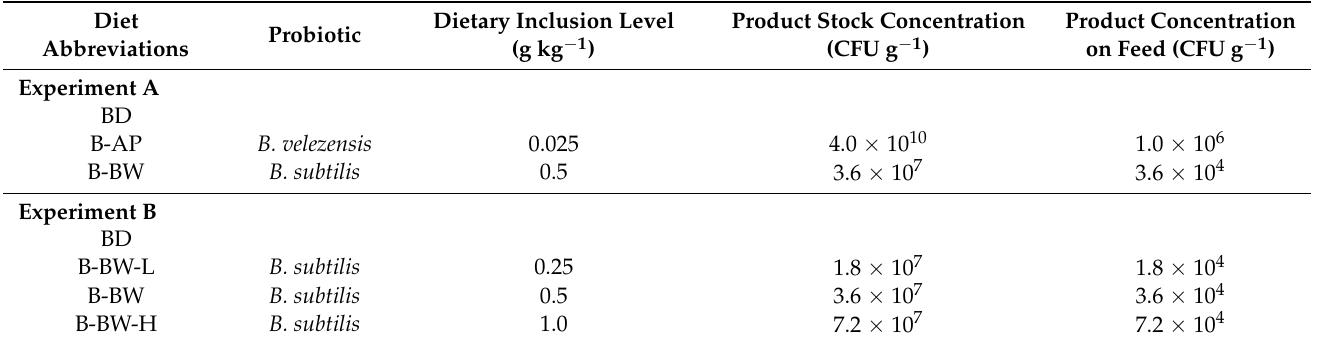
Table 2. Experimental diets abbreviations of probiotic types, inclusion levels, and concentrations fed to channel